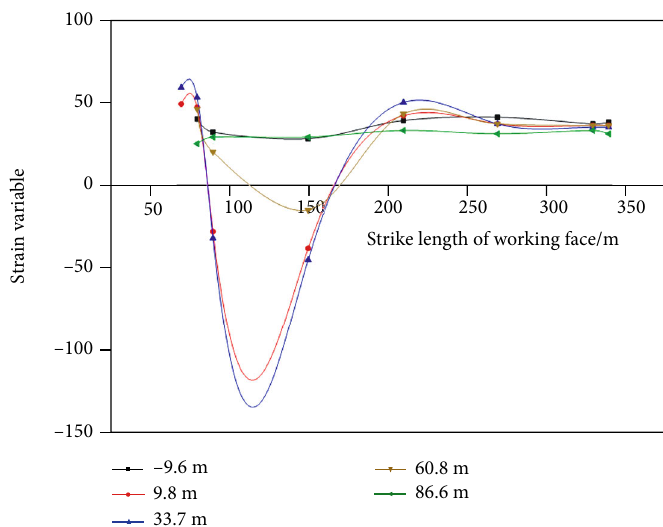
Figure 3: The stress variation curve of 600 m deep mining model when advancing 120m.